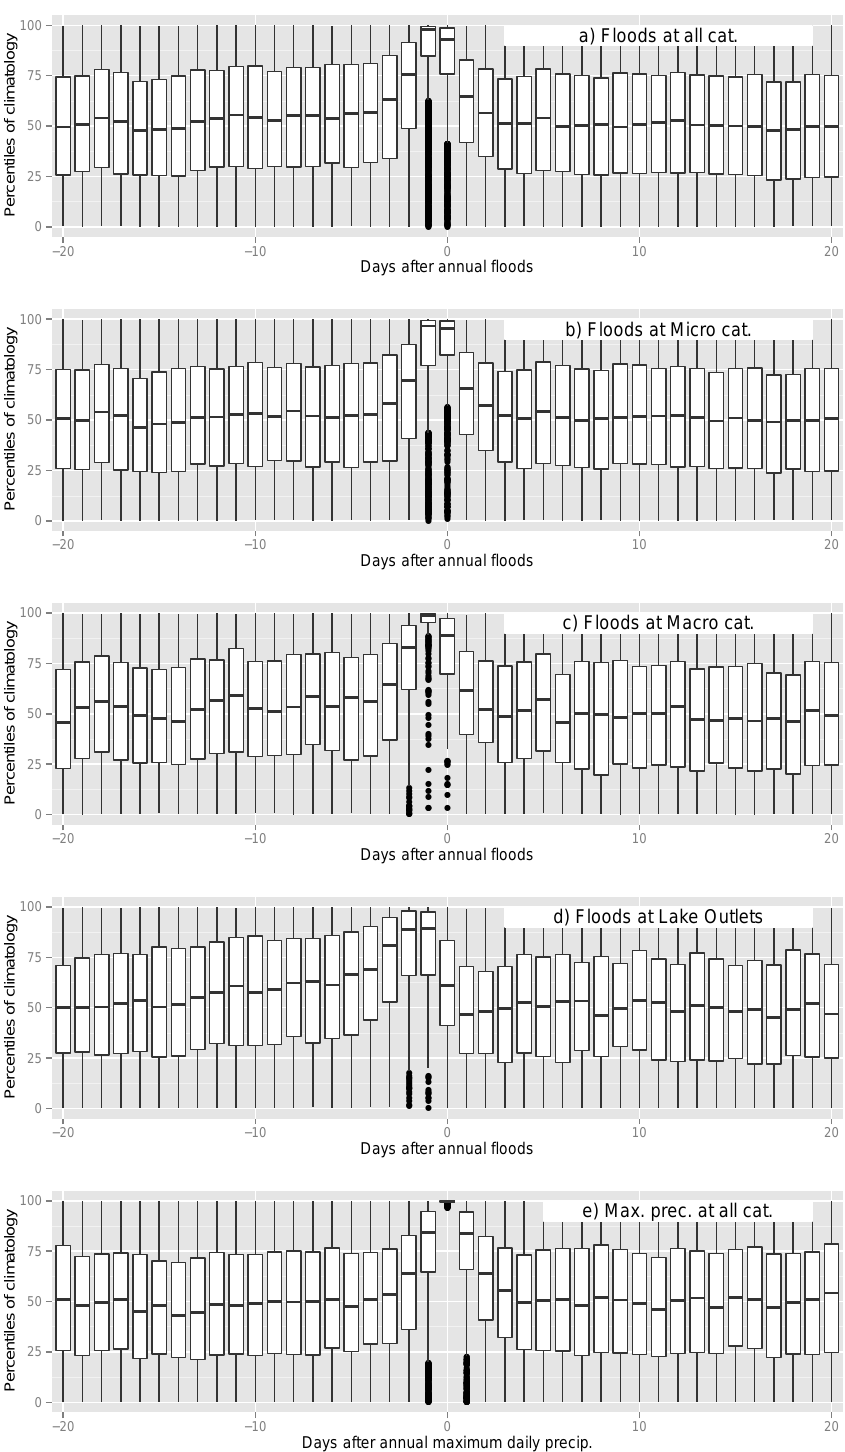
Figure 2. The distribution of daily precipitation before and after all flood events is shown in (a) . For example, the boxplot at x =− 10 represents the distribution of daily precipitation percentiles 10 days prior to the 4257 annual flood events analyzed in this study (all HQs from all catchments). The middle line of the boxplots shows the median, the boxes comprise the 25–75 percentile range, and the whiskers end at a deviation from the mean of 1.5 the interquartile range. (b) – (d) Same as (a) but for floods in Micro catchments, Macro catchments and Lake Outlets. (e) The same procedure as in (a) , but applied to annual maximum precipitation days instead of annual flood